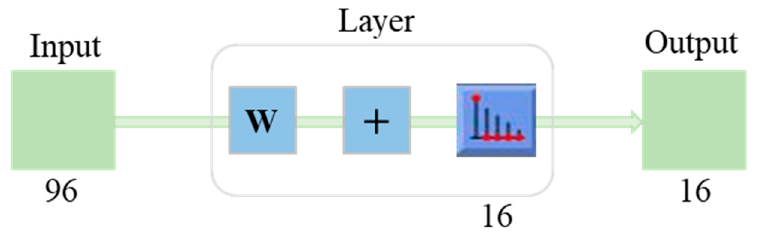
Figure 4. Schematic diagram of the Self-organizing Feature Map (SOM) training model.